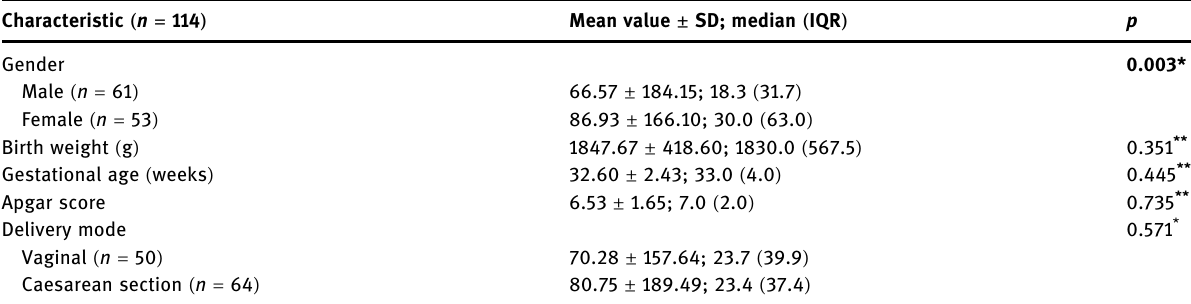
Table 1: Association of demographic characteristics of patients and calprotectin Characteristic ( n = 114 )